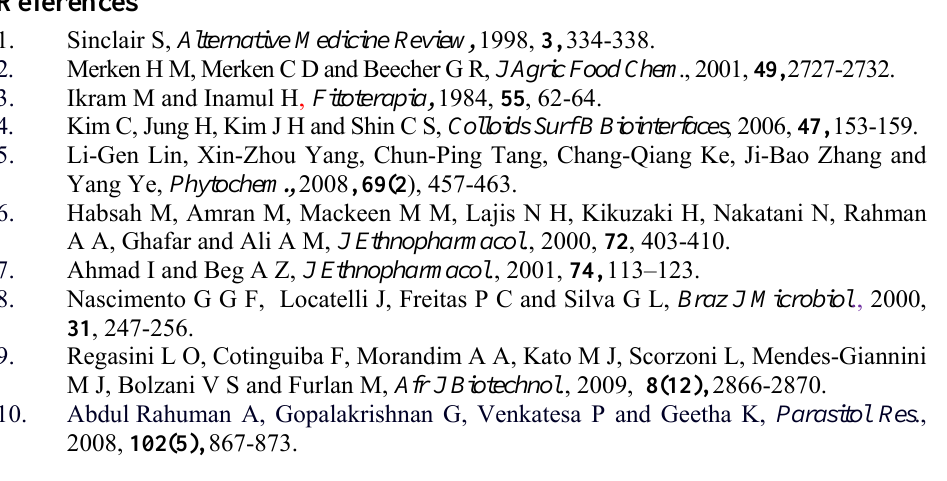
Table 1. Antimicrobial Activity of some herbs from UiTM Pahang Forest Reserve